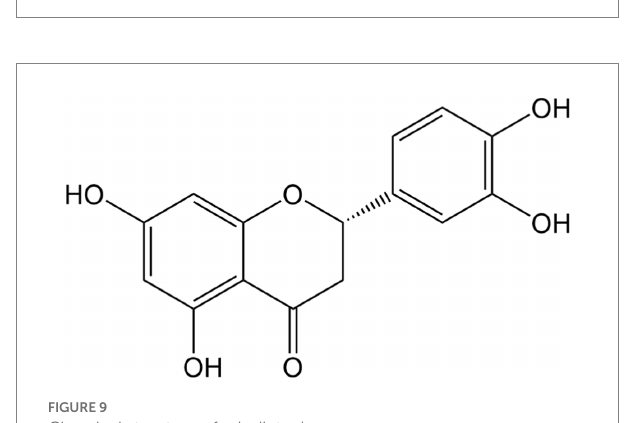
FIGURE 9 Chemical structure of